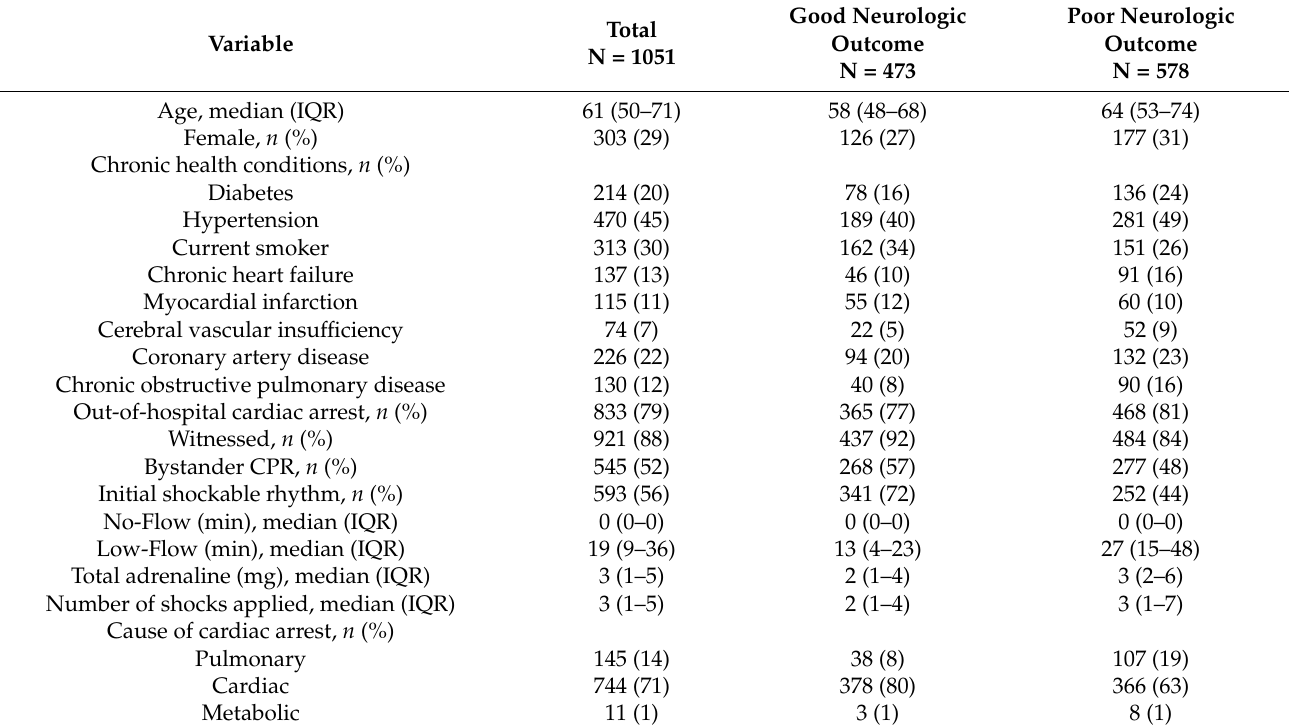
Table 1. Characteristics of study patients according to neurologic outcome on day